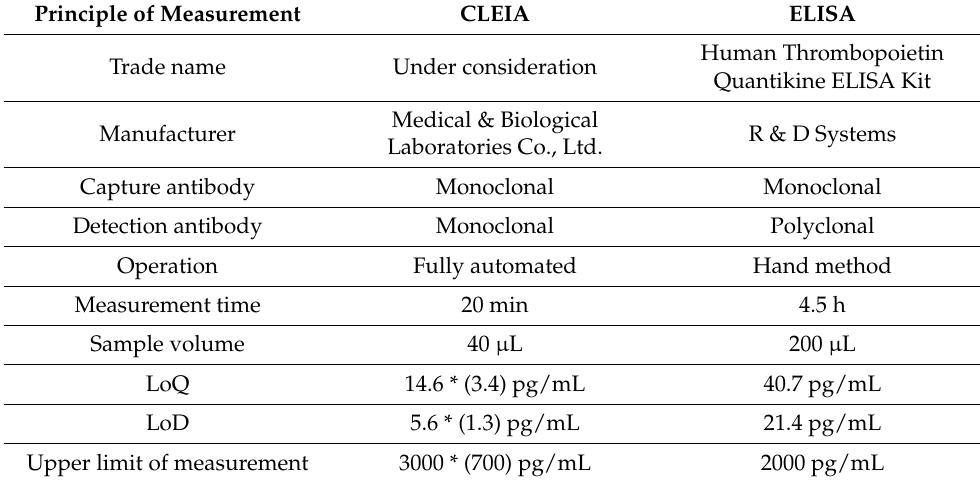
Table 6. Comparisons of features and performance between assays used for quantitative TPO